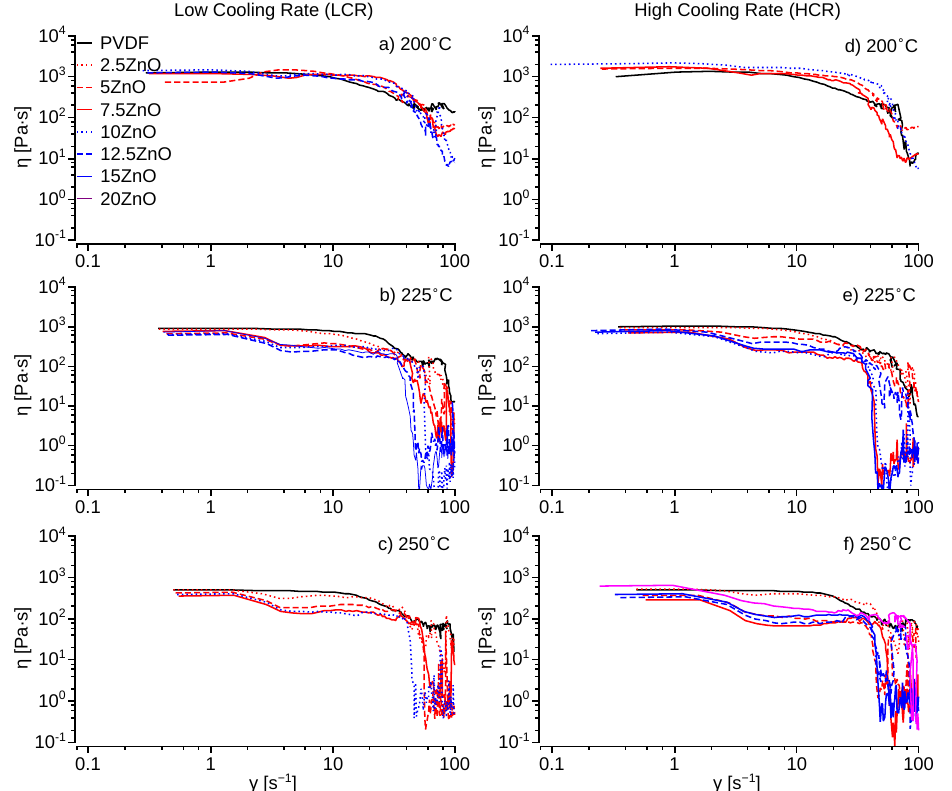
Figure 6. Shear viscosity η versus shear rate γ at different temperature profiles for low and high cooling rate 3D printed